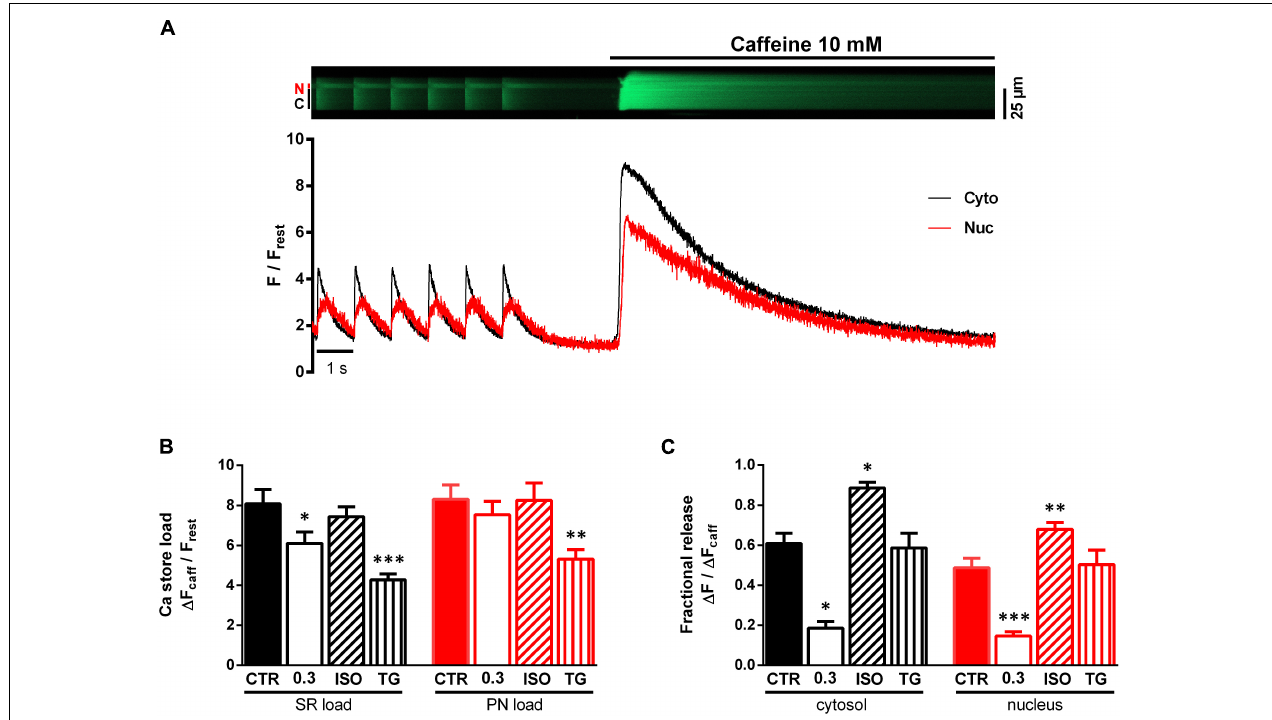
FIGURE 7 | Characterisation of SR and PN store load and fractional release (FR). (A) Representative original line-scan recording and corresponding normalized fluorescence trace, showing electrically evoked cytoplasmic (C, Cyto, black) and nucleoplasmic (N, Nuc, red) CaTs followed by a stop of stimulation and rapid caffeine (10 mM) application producing a caffeine-induced CaT. (B) Bar graph of average Ca store loads, demonstrating significantly decreased SR loads (black) at 0.3 mM Ca and after treatment with TG. Additionally, TG induced a reduction of PN load (red). (C) Bar graph of average FR values. FR was decreased at 0.3 mM Ca and increased under ISO stimulation. TG did not alter FR. ∗ P < 0.05, ∗∗ P < 0.01, ∗∗∗ P < 0.001 vs CTR, Ca 0.3: n / N = 9/5, ISO: n / N = 13/4, TG: n / N = 8/2, CTR: n / N =